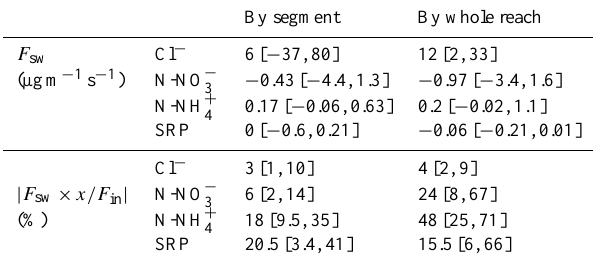
Table 3. Median and interquartile range [25th, 75th percentile] of in-stream net nutrient uptake flux ( F sw ) and the potential of F sw to modify solute input fluxes ( | F sw × x/F in | ) for the two spatial scales considered (stream segment and whole reach) during the study pe- riod. n = 150 and 10 for segments and whole-reach data sets, re-